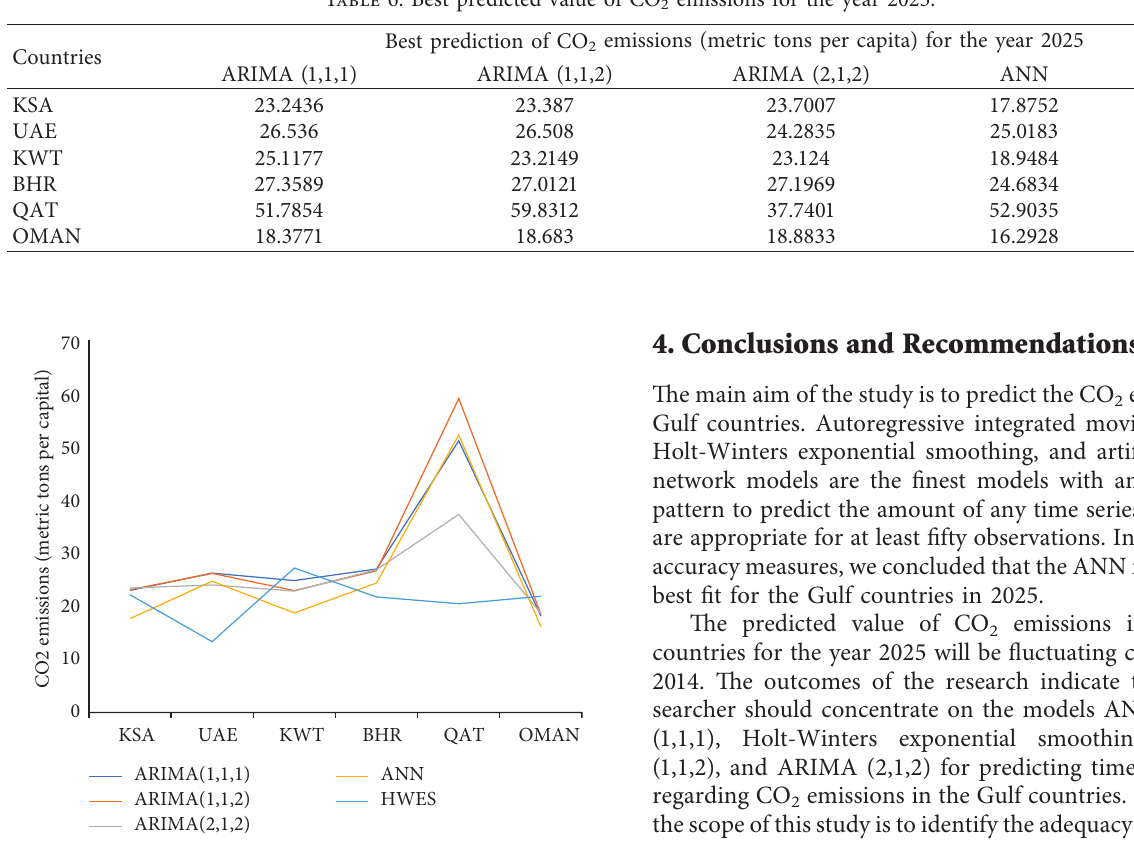
2 emissions for the year 2025.